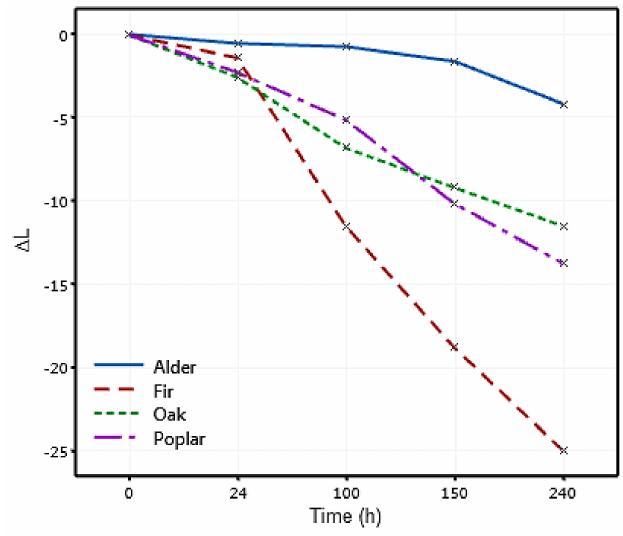
Figure 6. Variation in the lightness ( ∆ L ) of different wood species under artificial weathering.